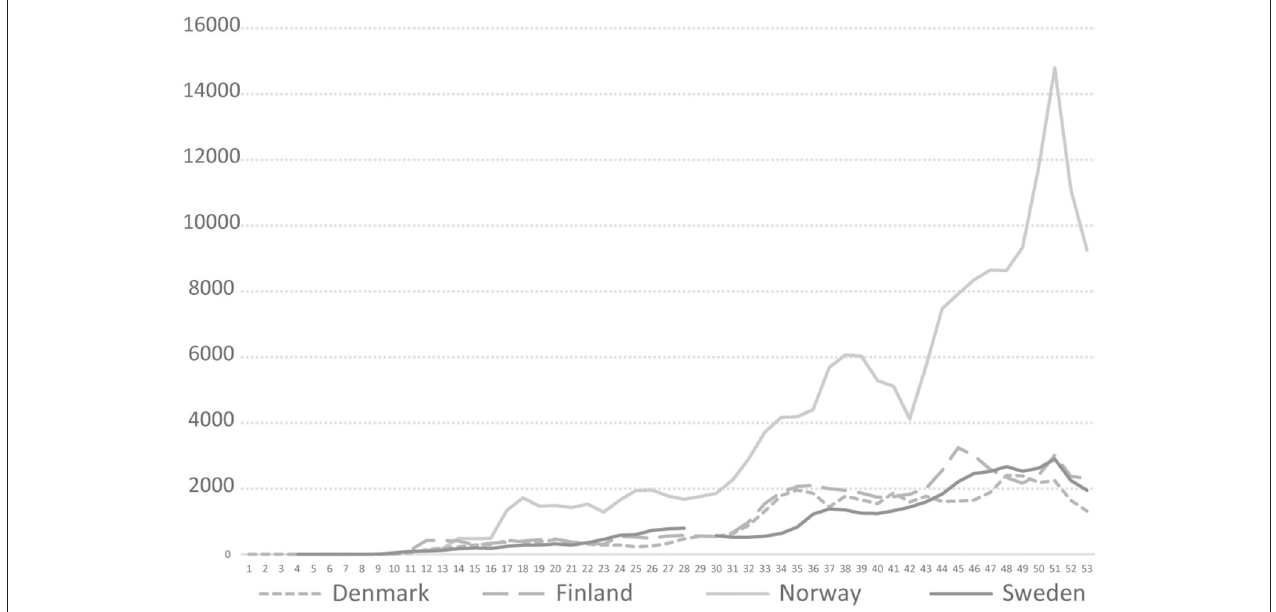
FIGURE 1 | COVID-19 testing rate per 100,000 in four Nordic countries during 2020, Weeks 1–53, 2020. https://www.ecdc.europa.eu/en/publications-data/COVID-